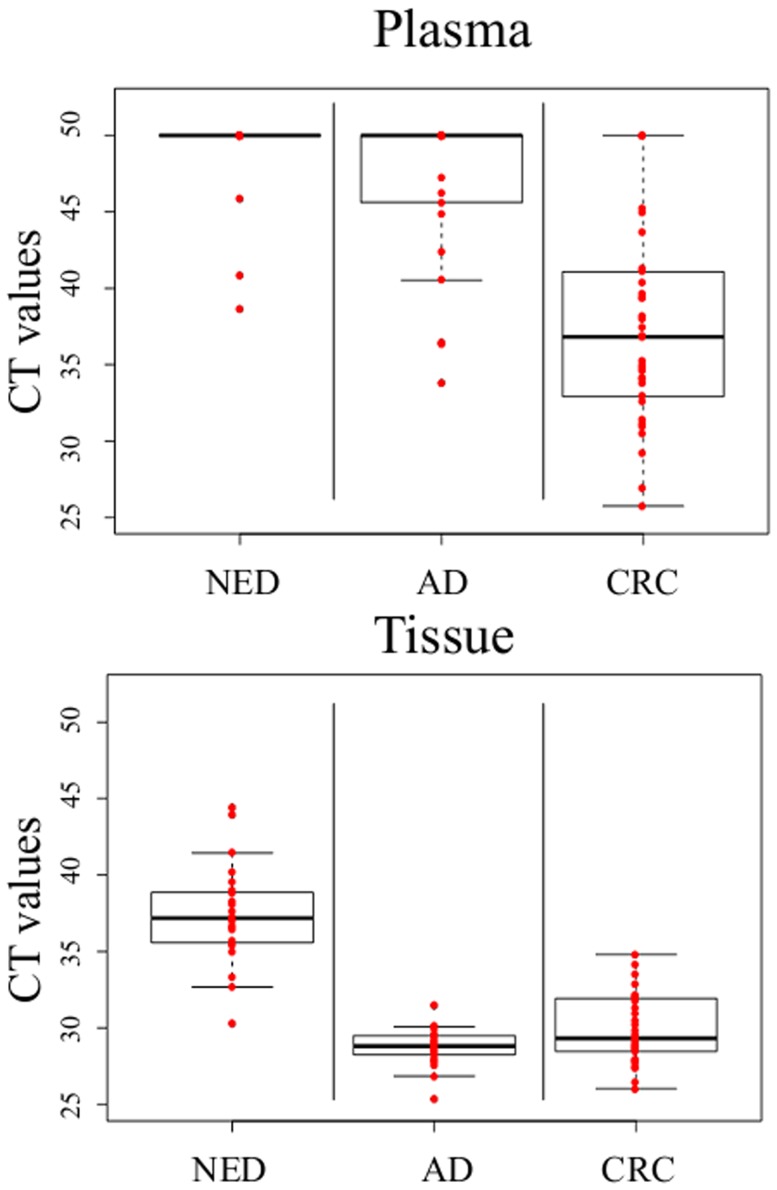
CT values of the assay for mSEPT9 in tissue and plasma samples.Box-plot graphs of CT values for mSEPT9 from healthy (NED - no evidence of disease), adenoma (AD) and cancer (CRC) tissue and plasma samples. The upper and lower edges of each box plot represent the 25th percentile and the 75th percentile, respectively. The line across each box represents the median value for the variable. Individual values are plotted as red dots.